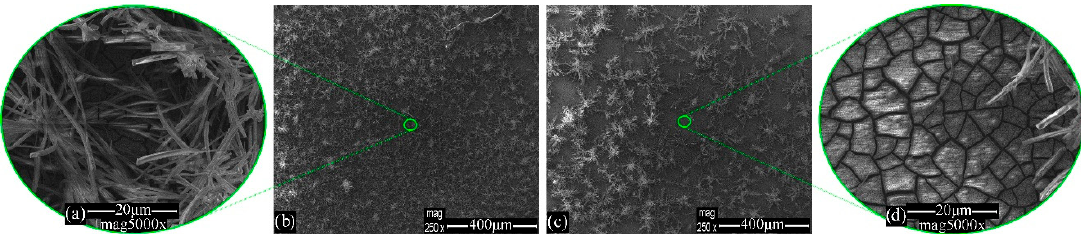
Figure 6. SEM images of mild steel immersed in WSS for 96 h in the presence of Na 2 HPO 4 and 2- mecraptobenzothiazole (MBT). The surface SEM images of mild steel subjected to 3.5 wt % NaCl ( Steel–NaCl–blank ) for 96 h are illustrated in Figure 7. It can be seen that there is a surface distinctly damaged by the saline solution, with the characteristic appearance of an etched layer near the metal surface, as chloride anions accelerate corrosion phenomena (Figure 7a,b). In several areas, bigger bulk crystalline tubular or rod- like forms of goethite (often visually yellowish to reddish rust) or hematite (visually metallic gray rust) [54,61]] and distinguishable cloud-like [3] lepidocrocite crystals are depicted (Figure 7c,e). As commented in preceding studies, it seems that small amounts of goethite were formed after a significant exposure time [3] by lepidocrocite solid transformation due to the presence of chloride ions as well as by the transformation of green rust (Fe II x Fe y III (OH) 3x+2y-z (A − ) z [54]) during the drying process (Figure 7d,e). The chloride ions, as aggressive anions, are considered [49] to accelerate the corrosion process, penetrating the protective layer and hence attacking the fresh unharmed metal surface beneath the layer, triggering pitting corrosion. Therefore, chloride anions may not be detected